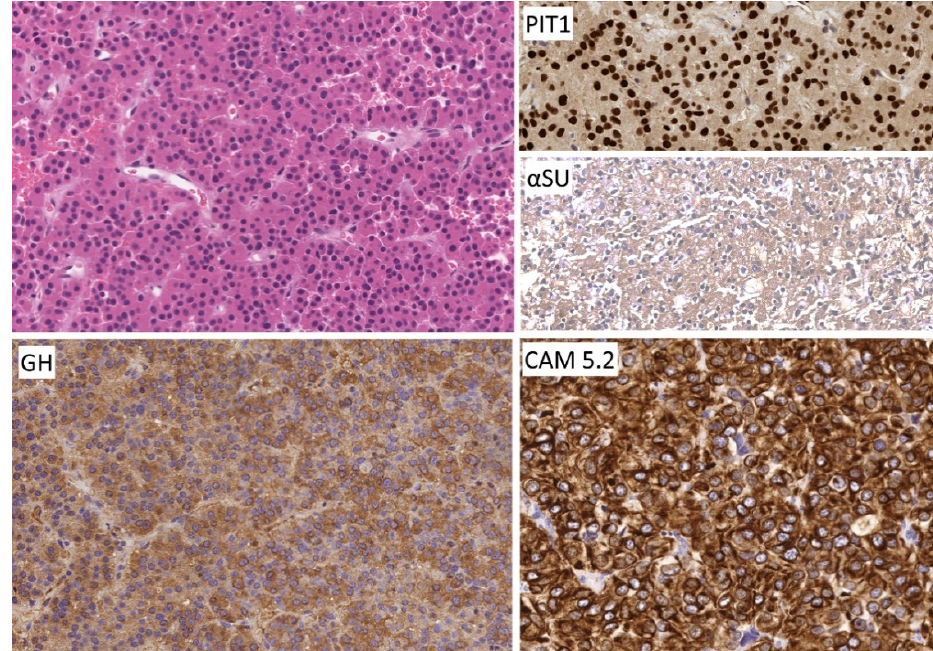
Figure 1. Morphology of densely granulated somatotroph tumor. The tumor cells with abundant acidophilic cytoplasm for solid nests and acini within a vascular stroma. The tumor cells exhibit strong PIT1 reactivity and diffuse cytoplasmic staining for GH as well as alpha subunit of glycoprotein hormones ( α SU). Staining for keratins shows perinuclear positivity. No scale bar on the program used.